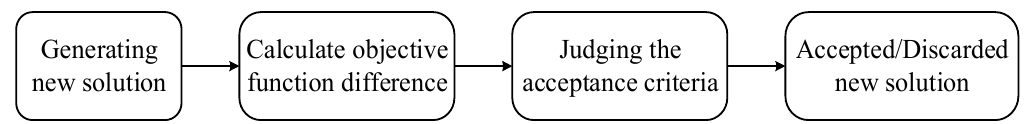
Figure 8. Simulated optimal annealing algorithm calculation process.